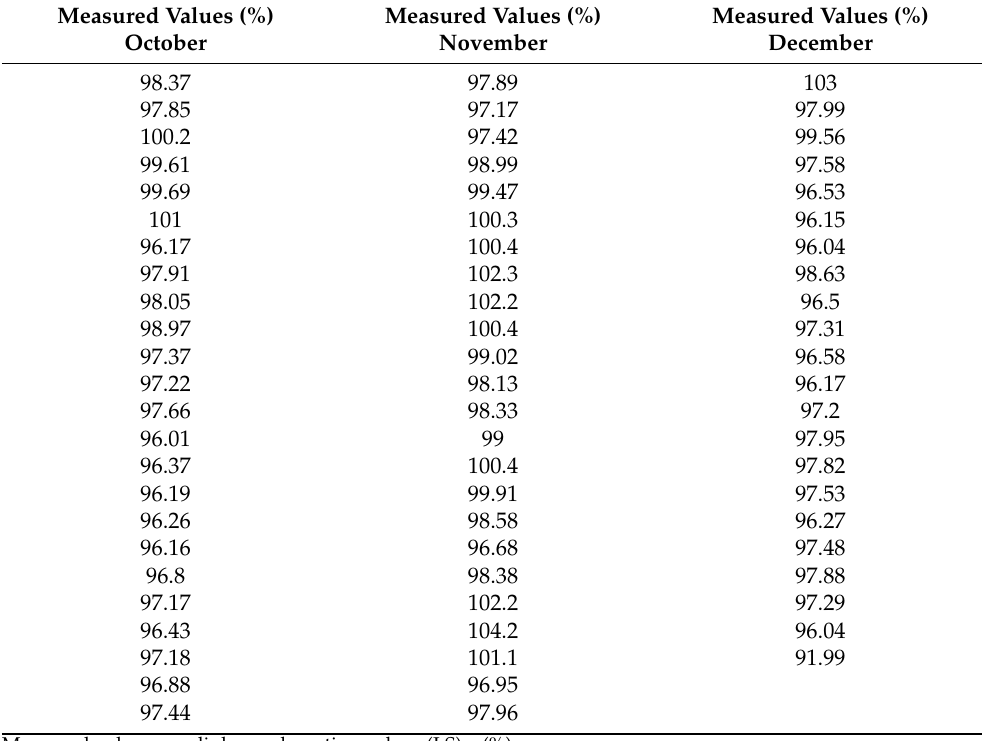
Table 1. Measured values—degree of clinker carbonation (LS) (%). Measured Values (%)